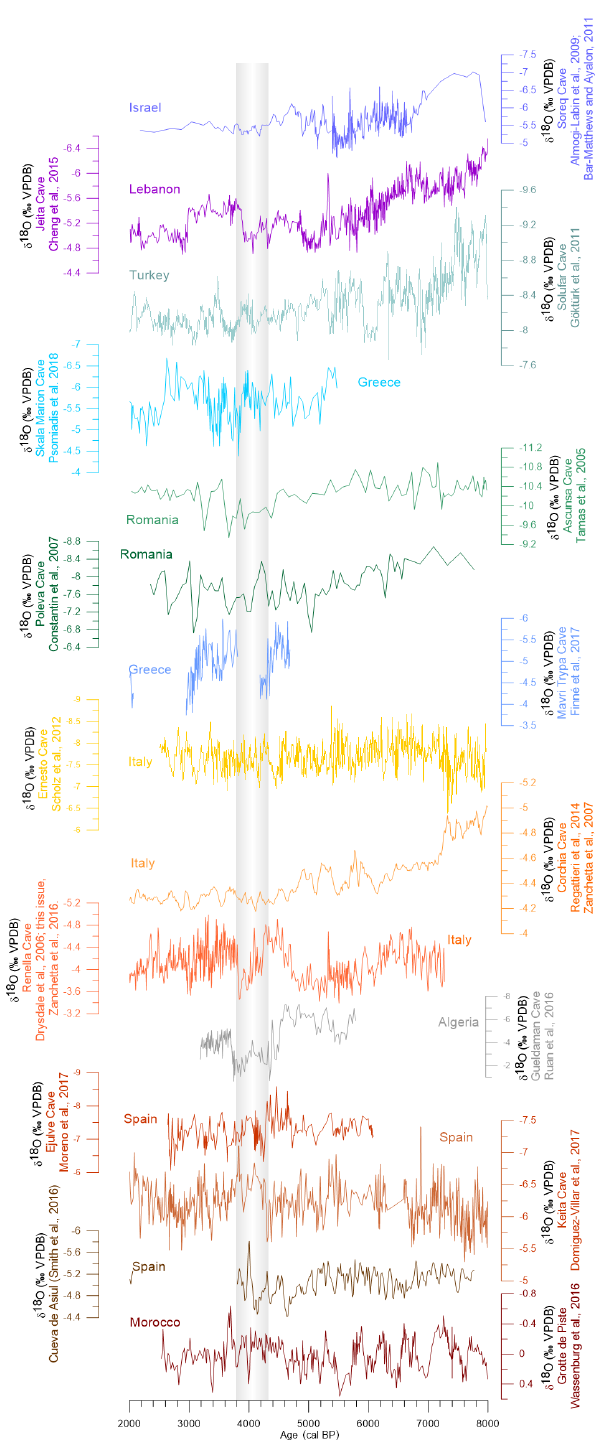
Figure 2. Selected speleothem δ 18 O records. For location, refer to Fig. 1 and for references to Table